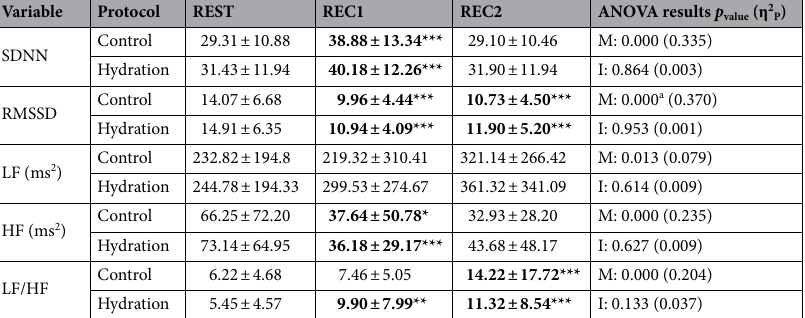
Table 3. Heart rate variability behavior for the 5-min windows in both protocols (N = 28). Mean ± standard deviation. Bold values: significantly different from REST. ms 2 millisecond squared, REST last 5 min of initial rest, REC1 first 5 min of recovery, REC2 5th–10th minute of recovery, M moments, I interaction moments versus protocol. ***